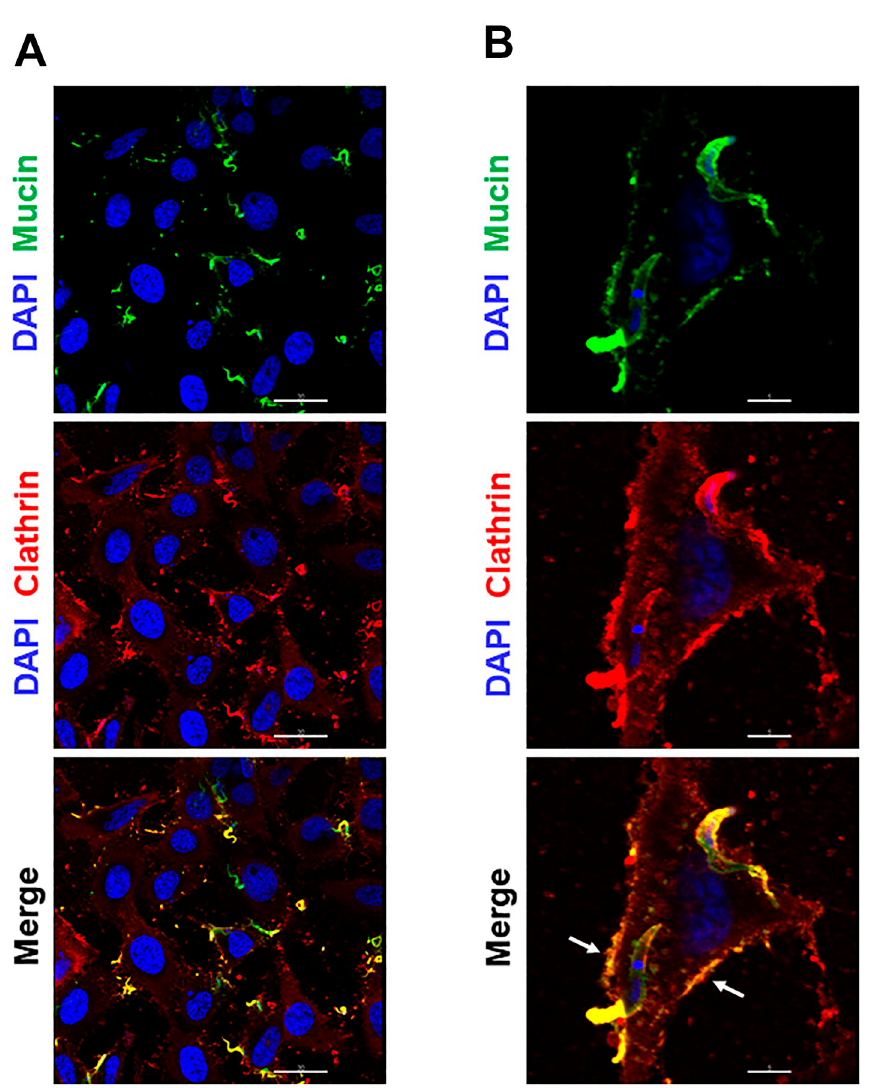
Fig 6. Colocalization of invading G strain MT and released gp35/50 mucins with host cell clathrin. ( A ) HeLa cells were incubated for 30 min with parasites and processed for immunofluorescence microscopy, using anti-clathrin antibody and mAb 10D8. The images show clathrin (red), parasite mucins (green) and nucleus (blue). Scale bar = 30 μ m. Note the colocalization of MT with clathrin. ( B ) A single cell with invading parasites is depicted to show the colocalization of clathrin with MT and also with shed gp35/50 mucins at the cell membrane (white arrows). Scale bar = 5 μ